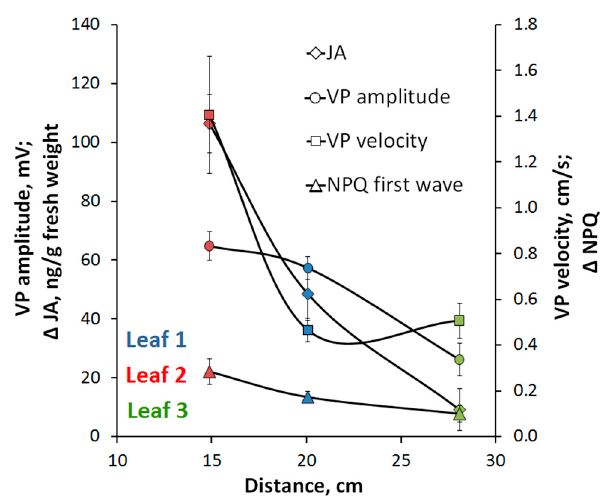
Figure 7. Dependence of the VP amplitude, VP velocity, the amplitude of the hormonal response and the photosynthesis response on the distance from the area of local stimulation according to the hypothetical scheme of long-distance signal propagation.